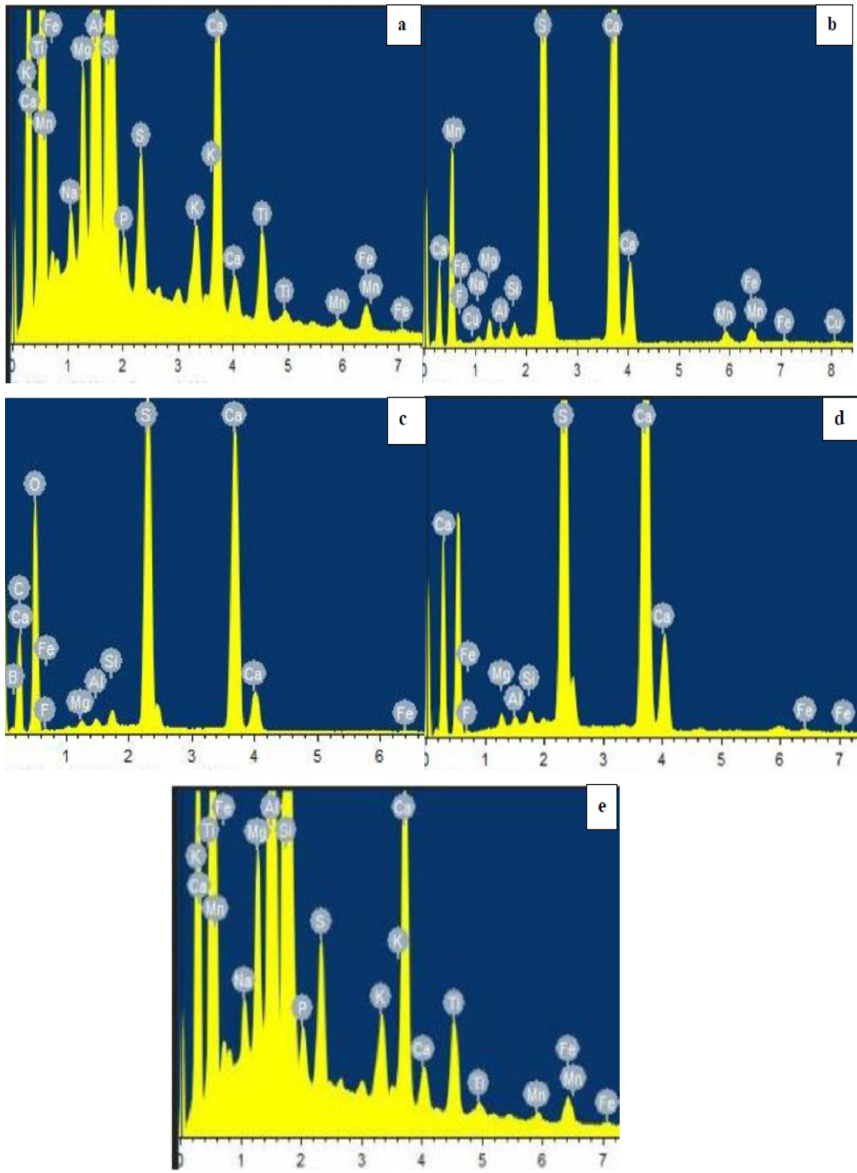
Figure 11. EDS analysis of WFGD gypsum cured at ambient temperature (( a ) 7 days, ( b ) 21 days, ( c ) 28 days, ( d ) 56 days and ( e ) 90 days).